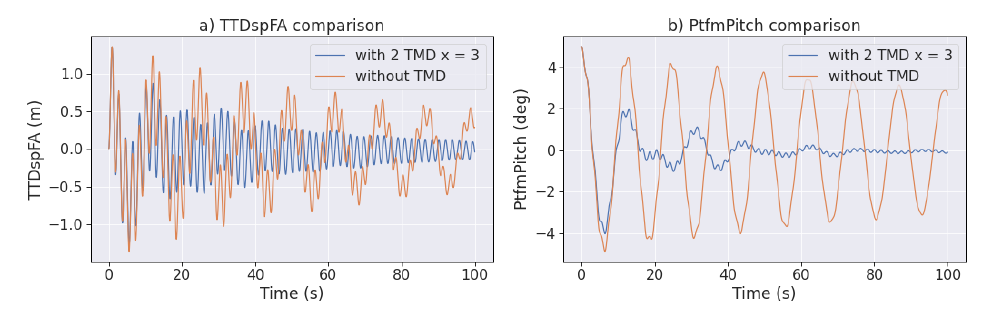
Figure 11. Comparison of TTDspFA ( a ) and PtfPitch ( b ) without TMD (orange) and with two TMDs located in the fore-aft axis at 3 m from the center